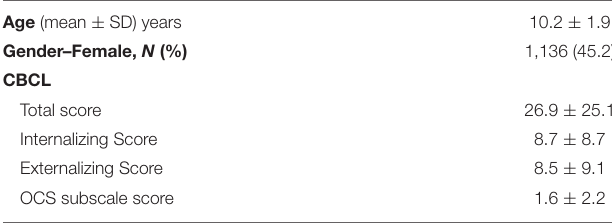
TABLE 1 | Maternal sociodemographic and clinical characteristics. TABLE 2 | Children’s sociodemographic and clinical